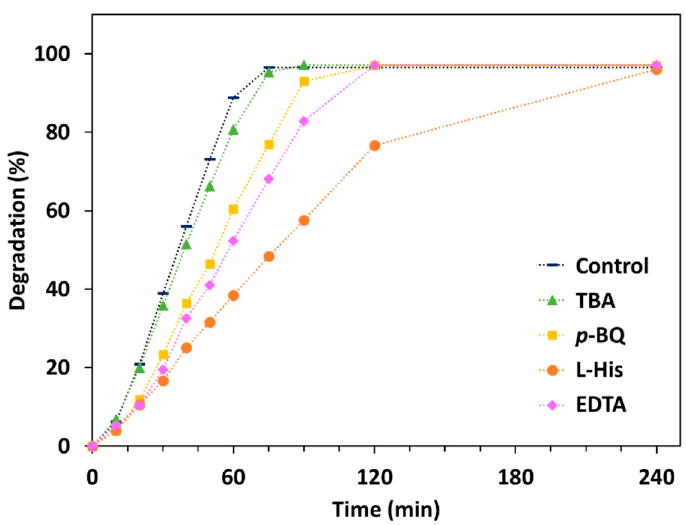
Figure 13. Effect of scavengers on the MB-degradation efficiency of catechol-HCP-Fe. Reaction conditions: [scavenger] = 1 mM, [catechol-HCP-Fe] = 1 g/L, [H 2 O 2 ] = 0.5 M, [MB] = 100 ppm, pH = 6 (neutral pH), room temperature (27 °C).